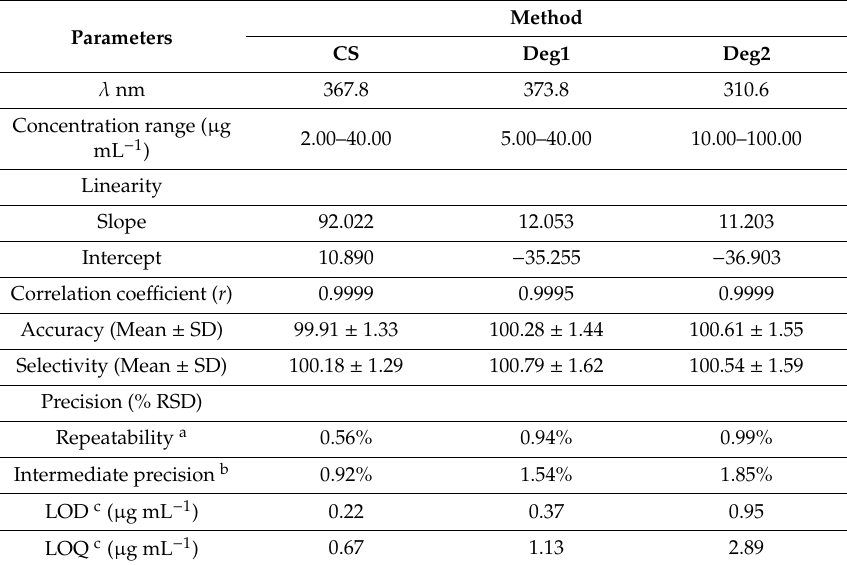
Table 1. Results of the validation parameters of the MCR method.